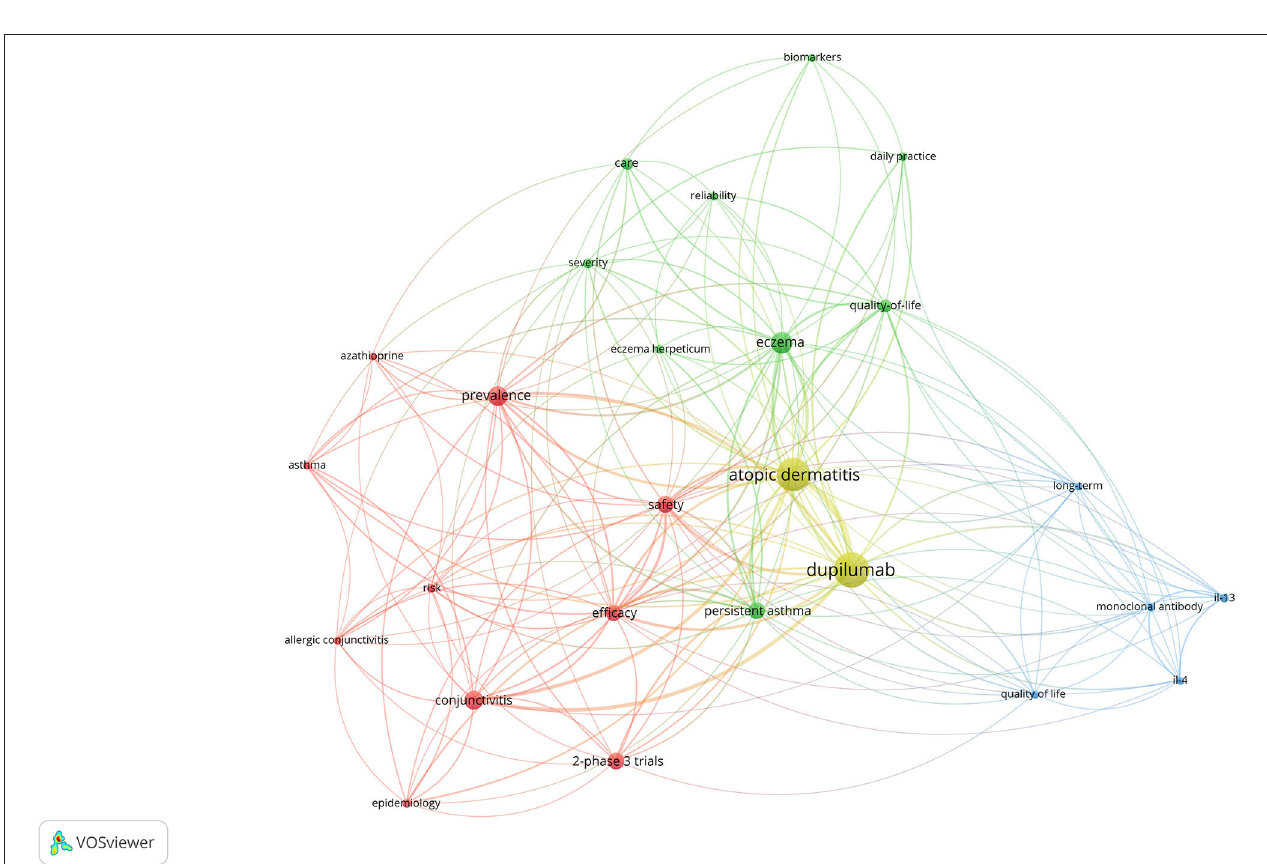
FIGURE 6 | The co-occurrence network of